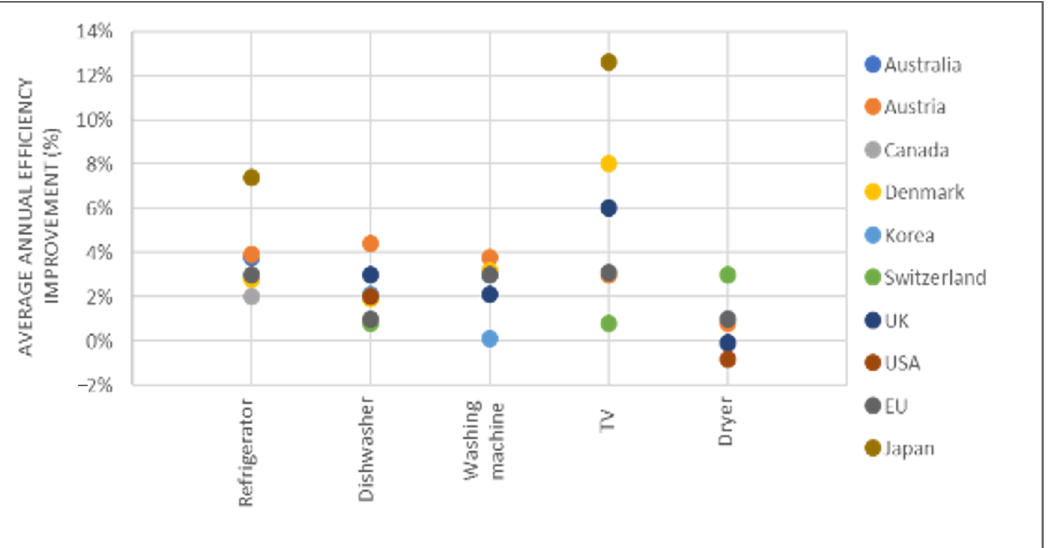
Figure 9. Annual efficiency improvement rates for different appliances in different countries, up to 2014, calculated for different time frames [39].